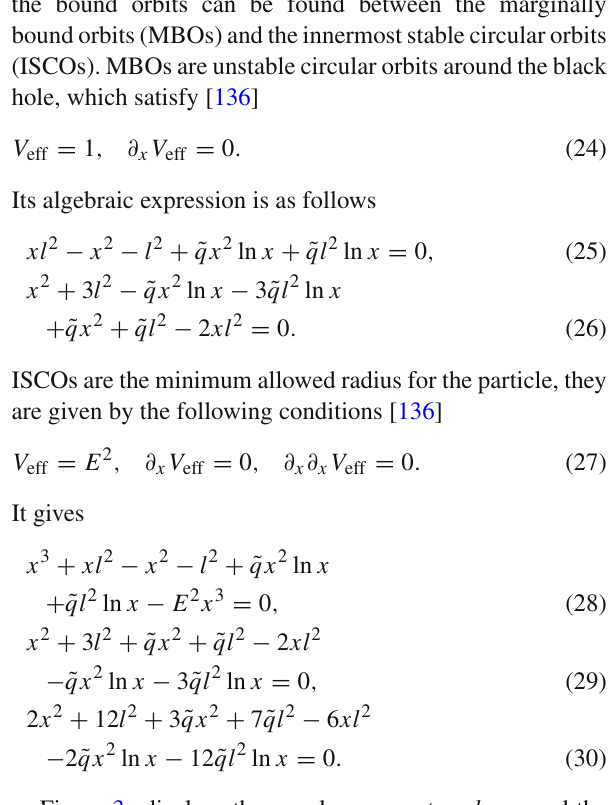
When the neutral timelike particle locates between MOBs and ISCOs around the black hole, one can analyse the par- ticles’s bound orbits by the aid of its effective potential and radial motion. The left column in Fig. 4 demonstrates V eff varies with x for different values of l (represented by various colors) and ˜ q . The red curves denote MBOs, which have two extreme points. ISCOs is represented as the purple curves with only one extreme point. It suggests that V eff decreases with the angular momentum l . At the same time, the max- imum point and the minimum point are getting closer with decrease of l until they become one at ISCOs. The right column in Fig. 4 shows the variation of ˙ x 2 with different values ˜ q for l = ( l MBO + l ISCO )/ 2 and different values of E (displayed by various colors). Bound orbits can not exist when ˙ x 2 has a root or no root unless the curves